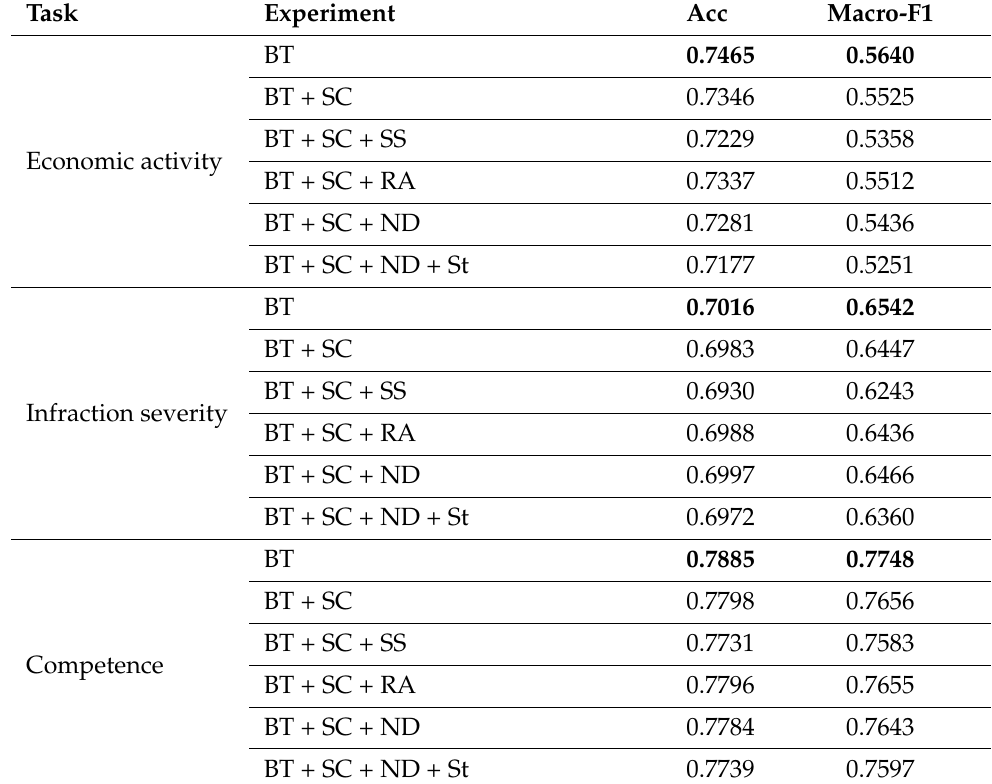
Table 14. Results obtained with further feature engineering, using SVM. ( BT = Base techniques; SC = Spell checking; SS = Synonym substitution; RA = Removal of accentuation; ND = Numerical data removal; St =